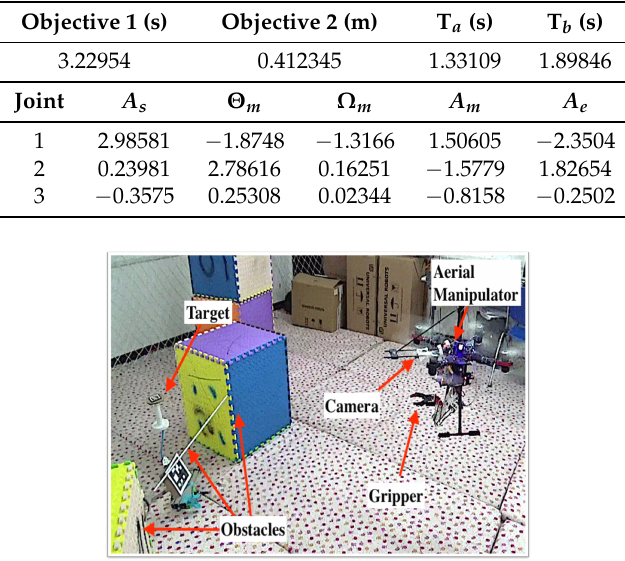
Figure 5. Manipulator and experimental object to be grasped.